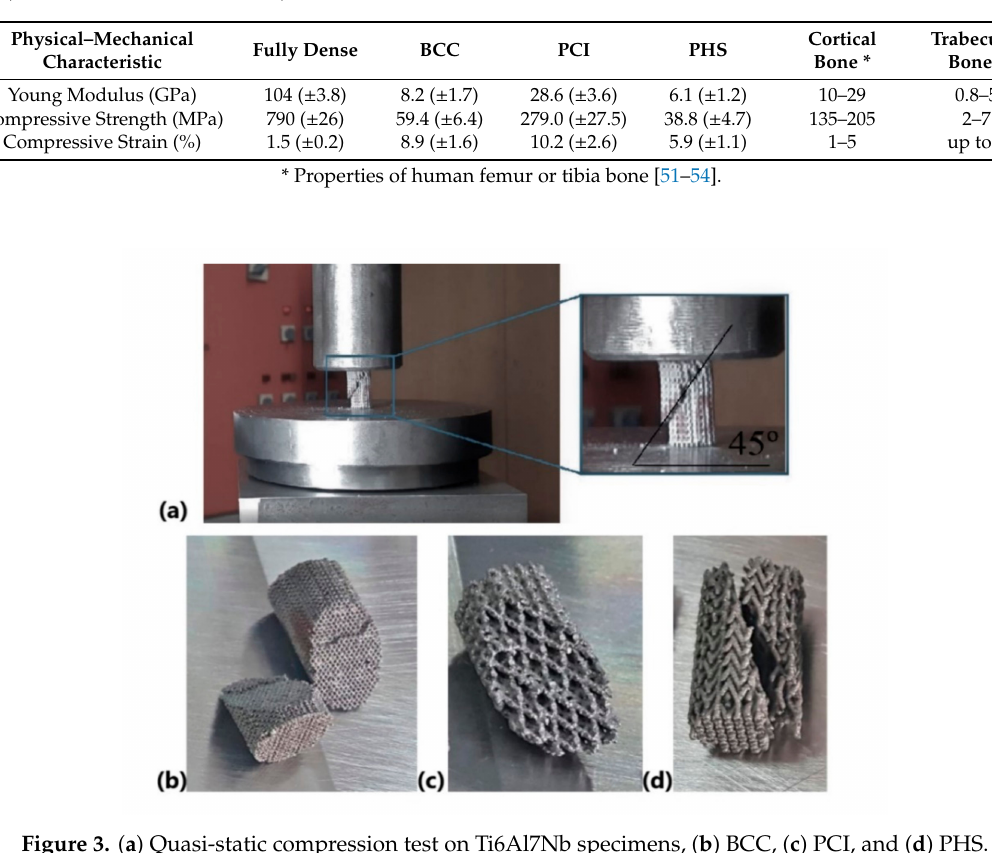
Figure 3. ( a ) Quasi-static compression test on Ti6Al7Nb specimens, ( b ) BCC, ( c ) PCI, and ( d )